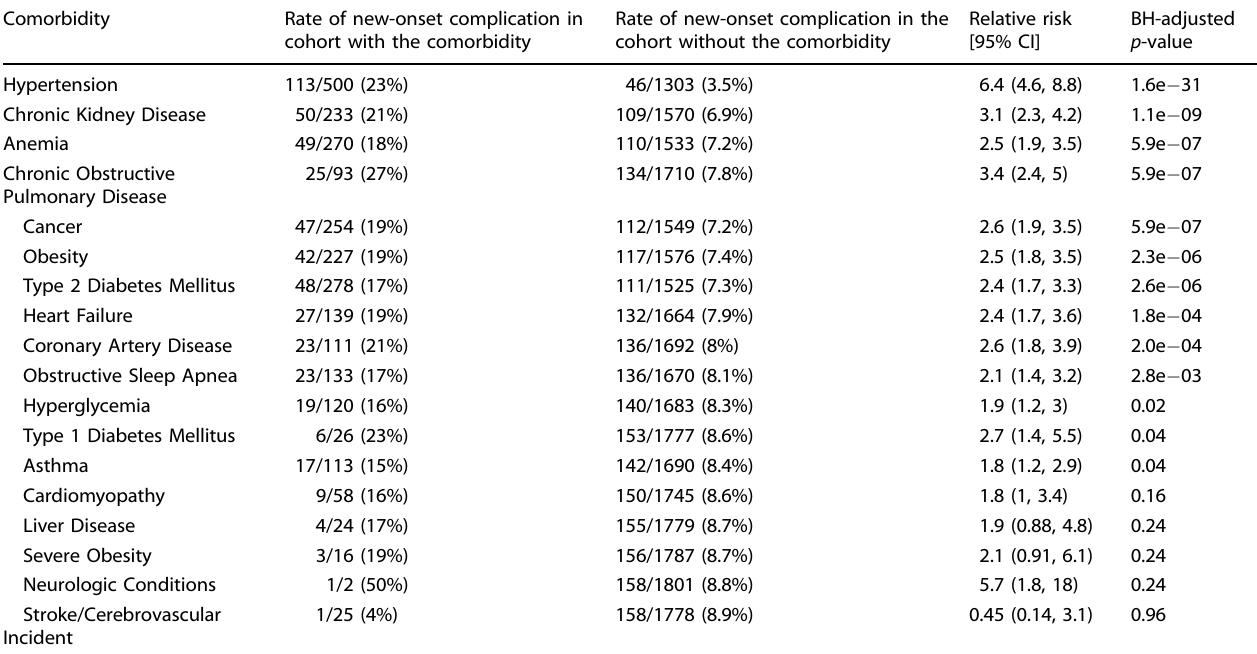
Table 2. Overall rates of early-onset complications strati fi ed by comorbidity. Comorbidity Rate of new-onset complication in Rate of new-onset complication in the cohort with the comorbidity cohort without the